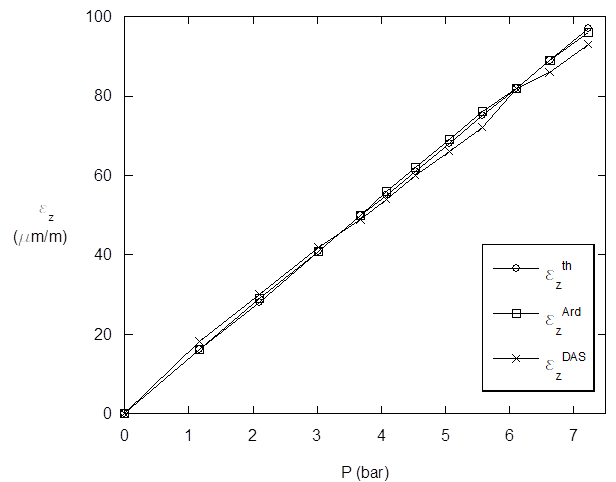
Figure 11. Comparison chart of the measurements obtained: ε th z , theoretical values; ε Ard z , SmartFire; ε DAS z , data Acquisition system. All values correspond to the longitudinal deformations ( ε z ) included in Table 2, and are expressed in microns. Notice that the longitudinal axis is used as reference for the deformations, whereas the transversal axis is used for validating the DAS measurements.